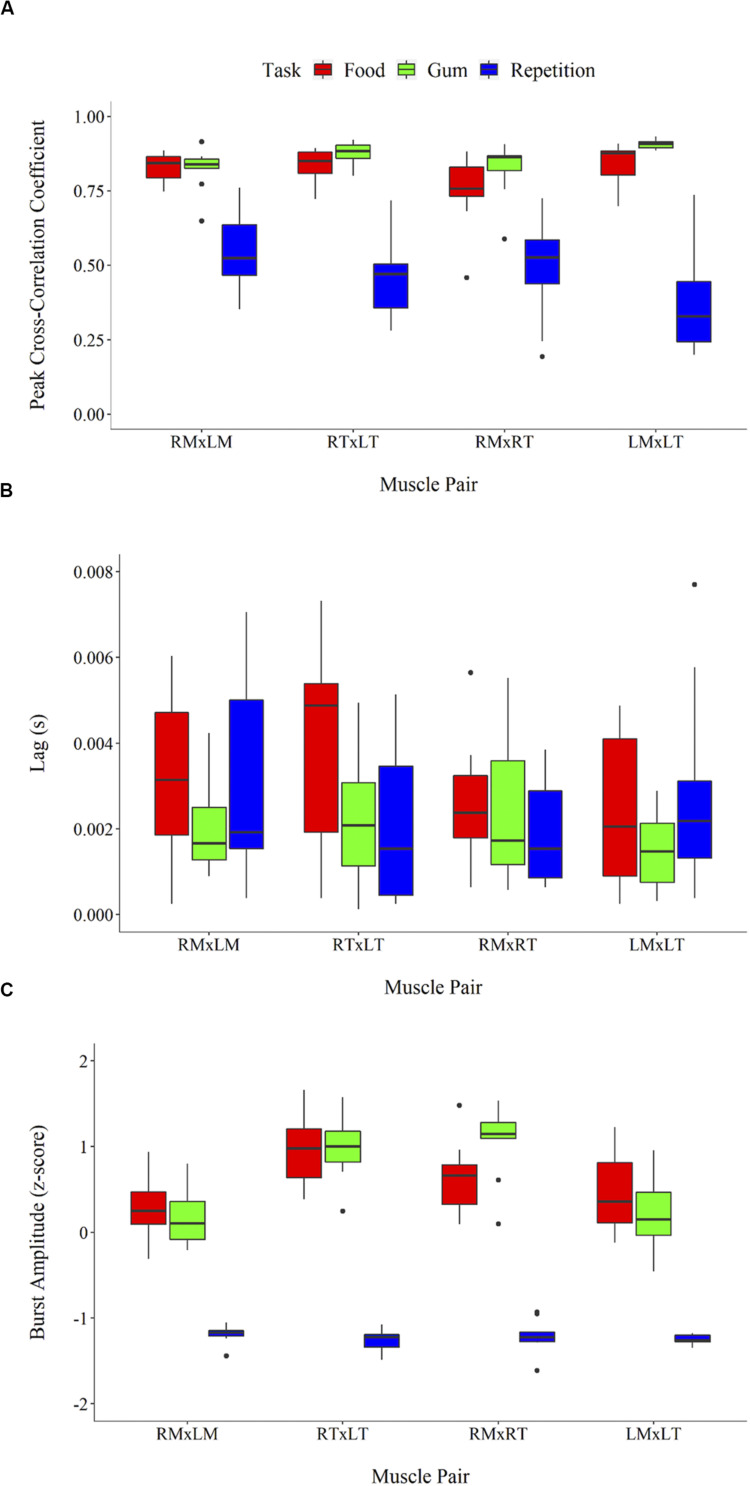
sEMG parameters including peak cross-correlation coefficient (A), associated lag (in seconds) (B), and burst amplitude (z-score root mean square) (C). Error bars represent standard error.